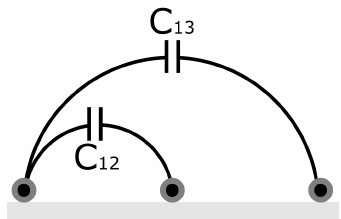
Figure 3. Capacitance between electrodes in differential measurement mode.